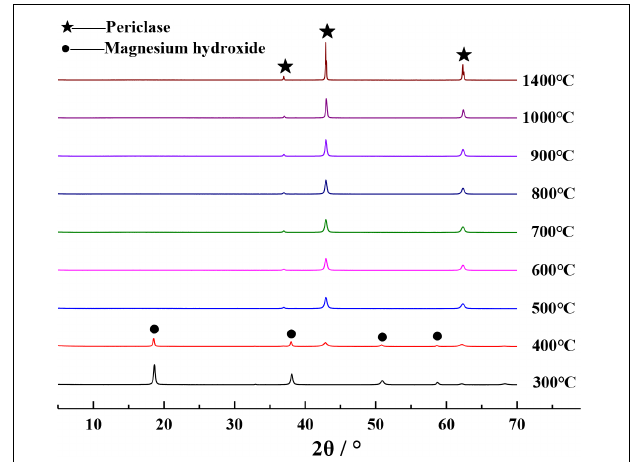
FIGURE 2 | XRD patterns of different magnesian raw materials calcined at a 1000 ◦ C furnace for 1 h.